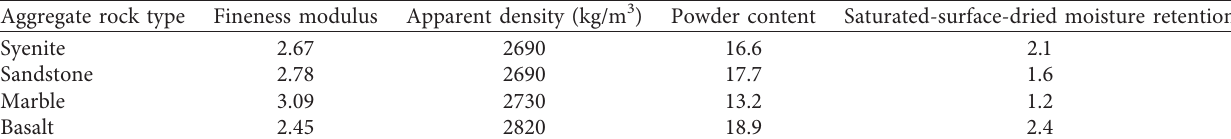
Table 6: Physical properties of